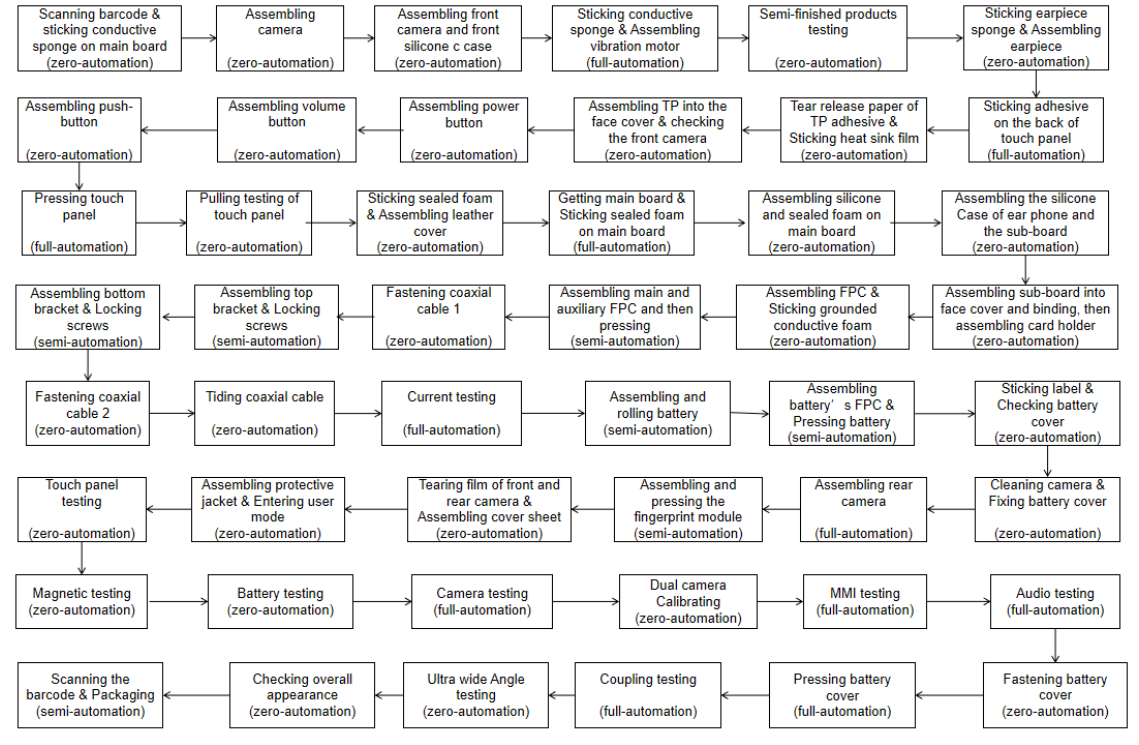
Figure 2. Station division and automatic analysis of a certain type of mobile